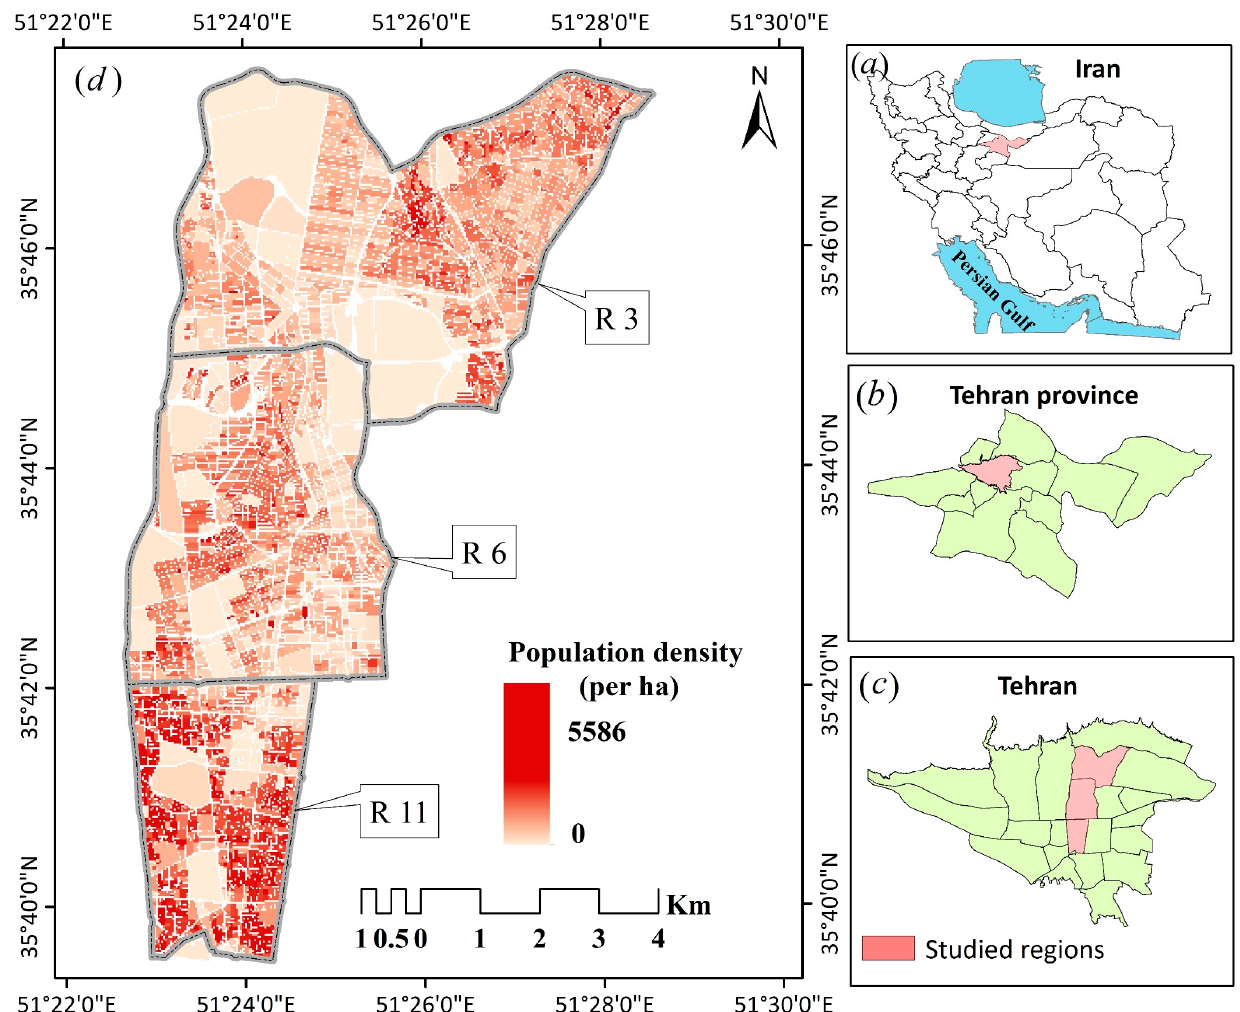
Figure 9. Location of the study area. ( a ) Iran, ( b ) Tehran province, ( c ) Tehran city, and ( d ) Districts 3, 6 and 11.